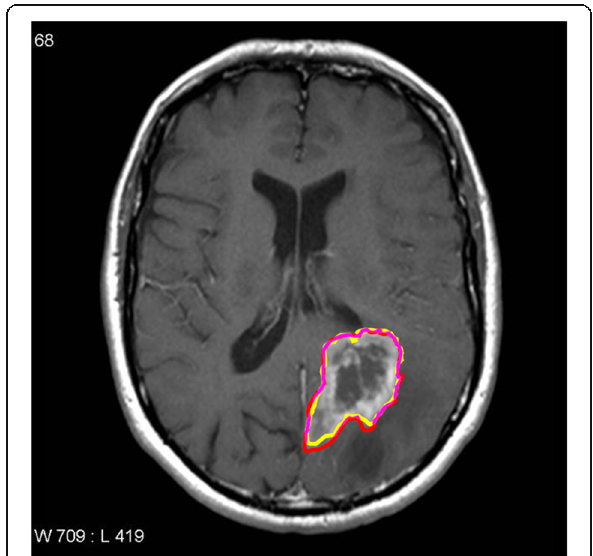
Fig. 1 Manual anatomical segmentation by first (red) and second author (yellow) with intersection (purple). Image courtesy of A.Prof Frank Gaillard, Radiopaedia.org, rID: